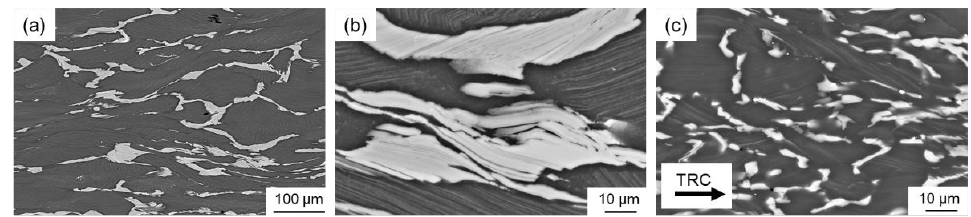
Figure 8. SEM images (15 kV, SE) of the deformed samples ( a ) as-cast condition, overview, ( b ) as-cast condition, detail and ( c ) TRC condition, detail.